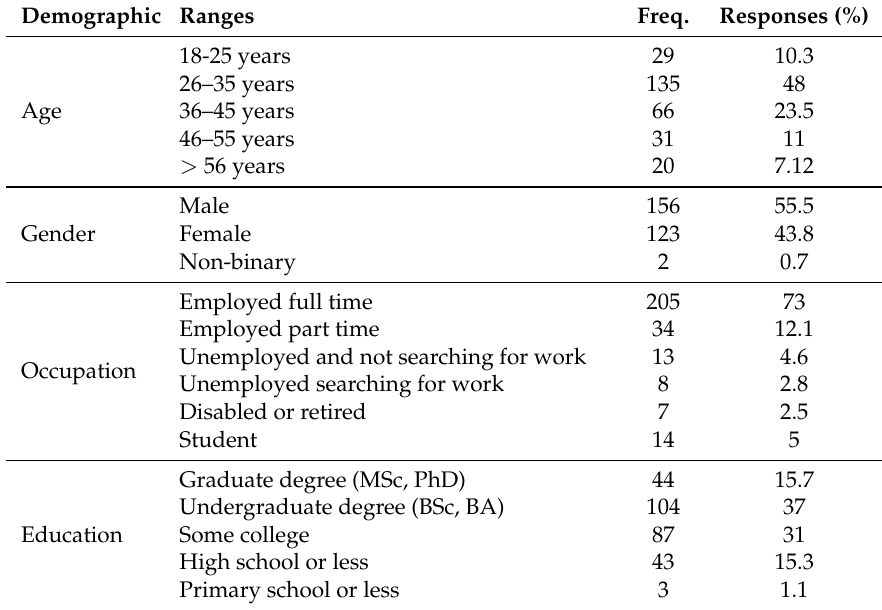
Table A1. Demographic characteristics of the studied sample.